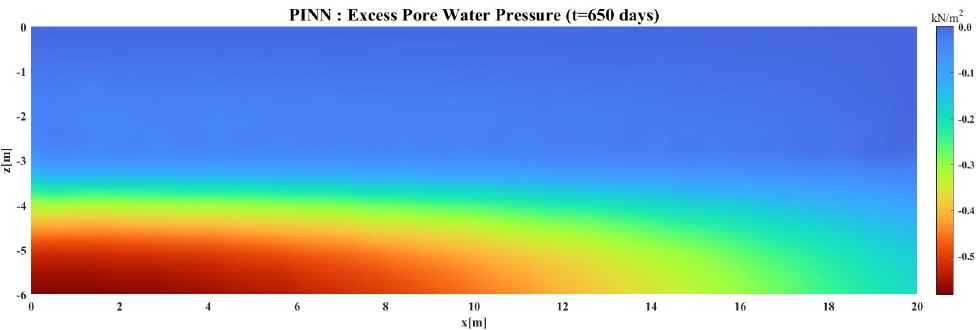
Figure 17. Color map of excess pore water pressure based on the proposed PINN-based